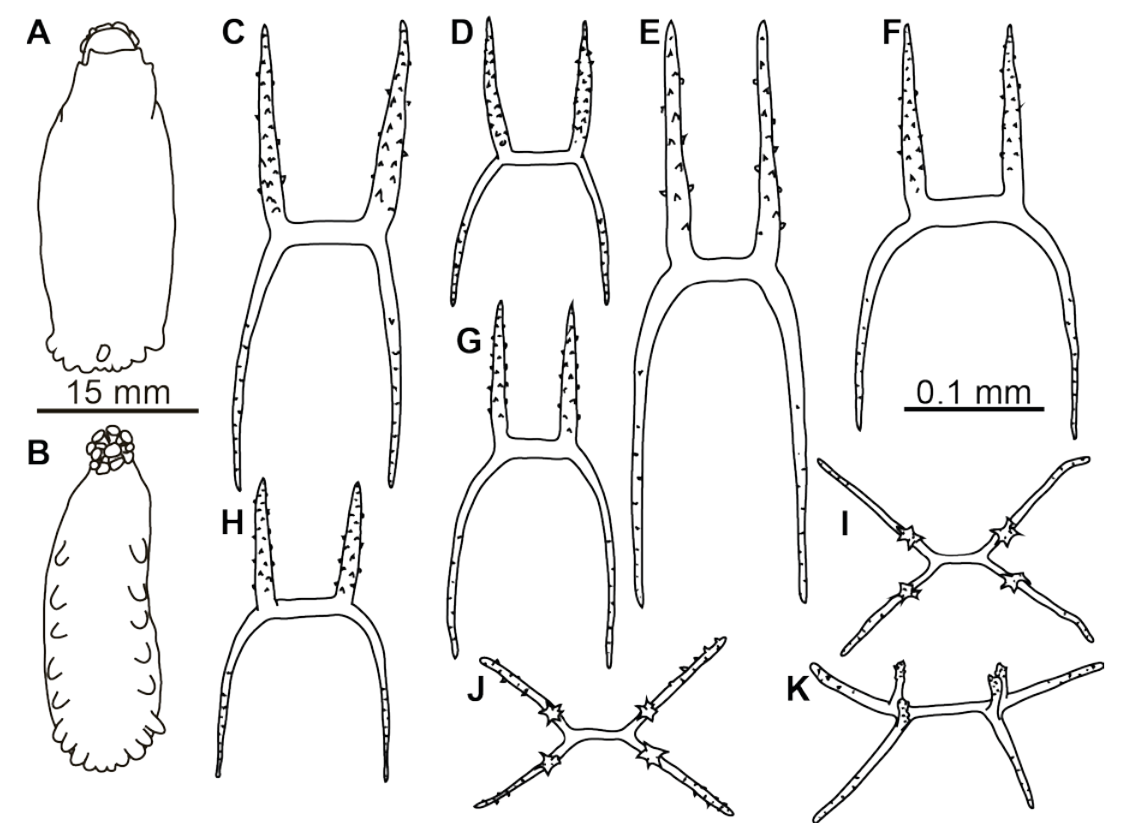
Figure 4. Peniagone mus . ( A , B ) RV Sonne , St. 03-10, dorsal and ventral view; ( C – K ) RV Sonne , St. 11-10, dorsal ( C – H ) and ventral ( I – K ) ossicles, scale 0.1 mm, a pair of arms omitted in dorsal ossicles.